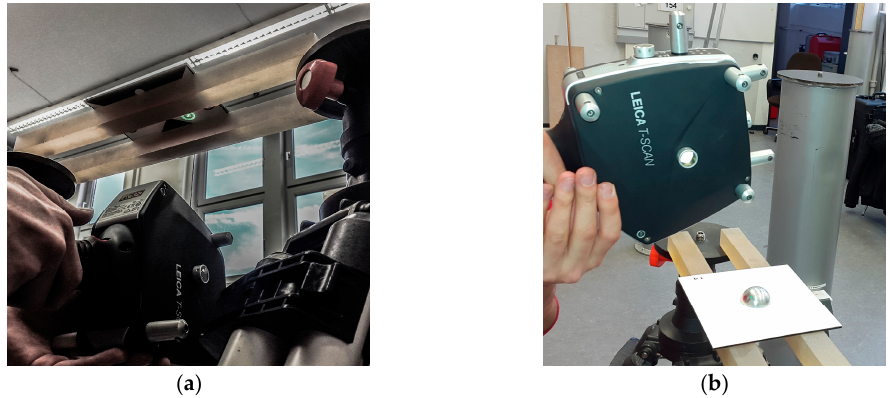
Figure 10. Scan of each targets ( a ) front side and ( b ) backside with Leica T-Scan 5 for the determination of the target radius.